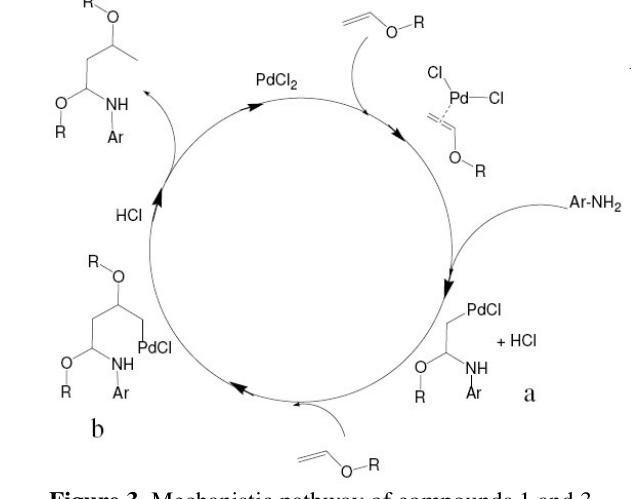
Figure 3. Mechanistic pathway of compounds 1 and